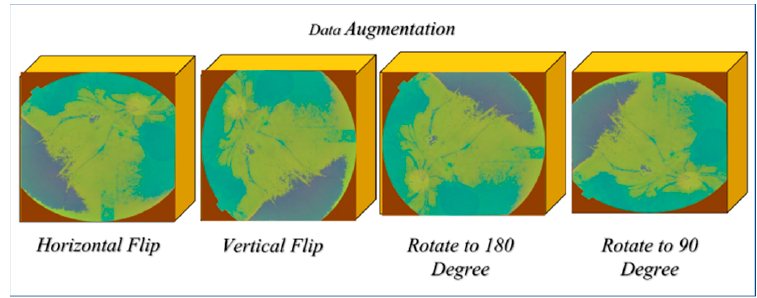
Figure 2. Illustrates the data